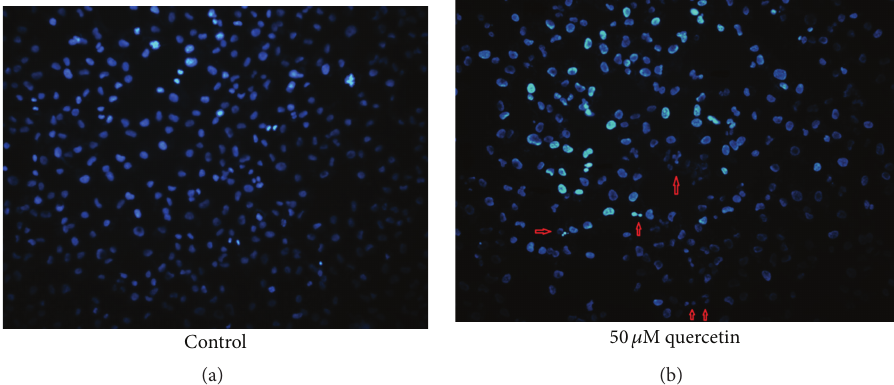
Figure 4: Chromatin staining of B-CPAP cells with Hoechst 33342. Arrows indicate blebbing and chromatin condensation. Fluorescence microscope: Leica DFC 310 FX, Magnification: